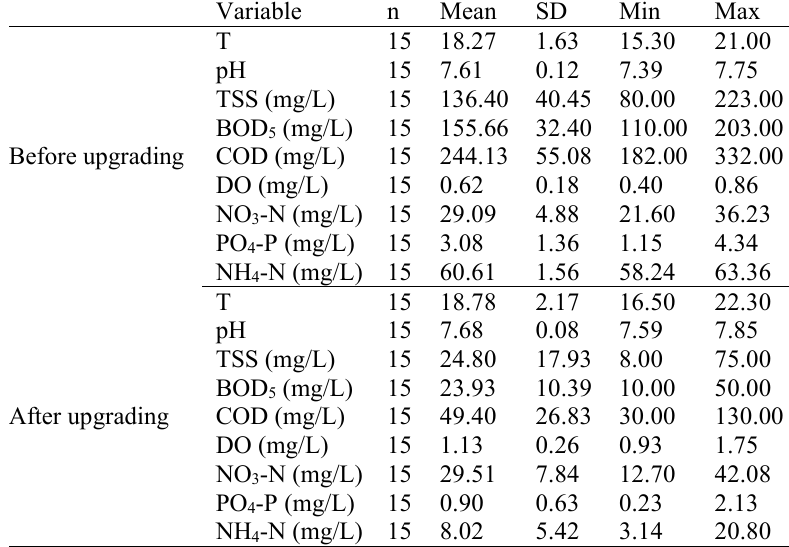
Table 5. Characteristics of Tafresh treated wastewater Variable